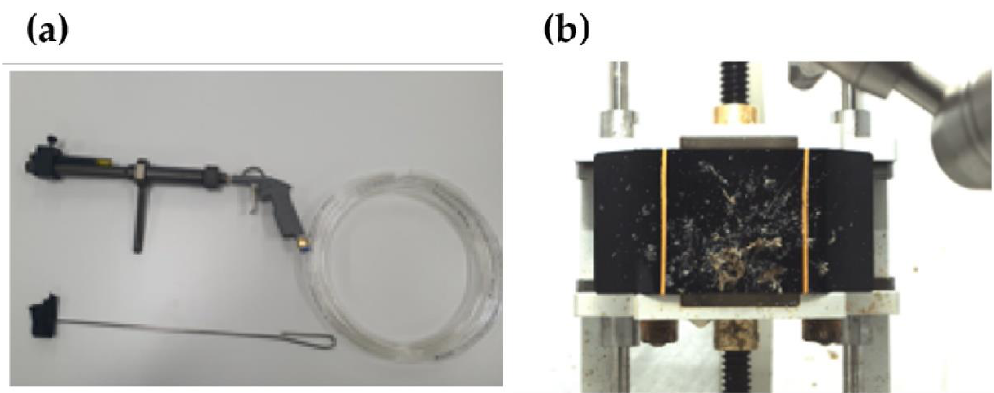
Figure 6. ( a ) Insect air gun; ( b ) after insect impact.